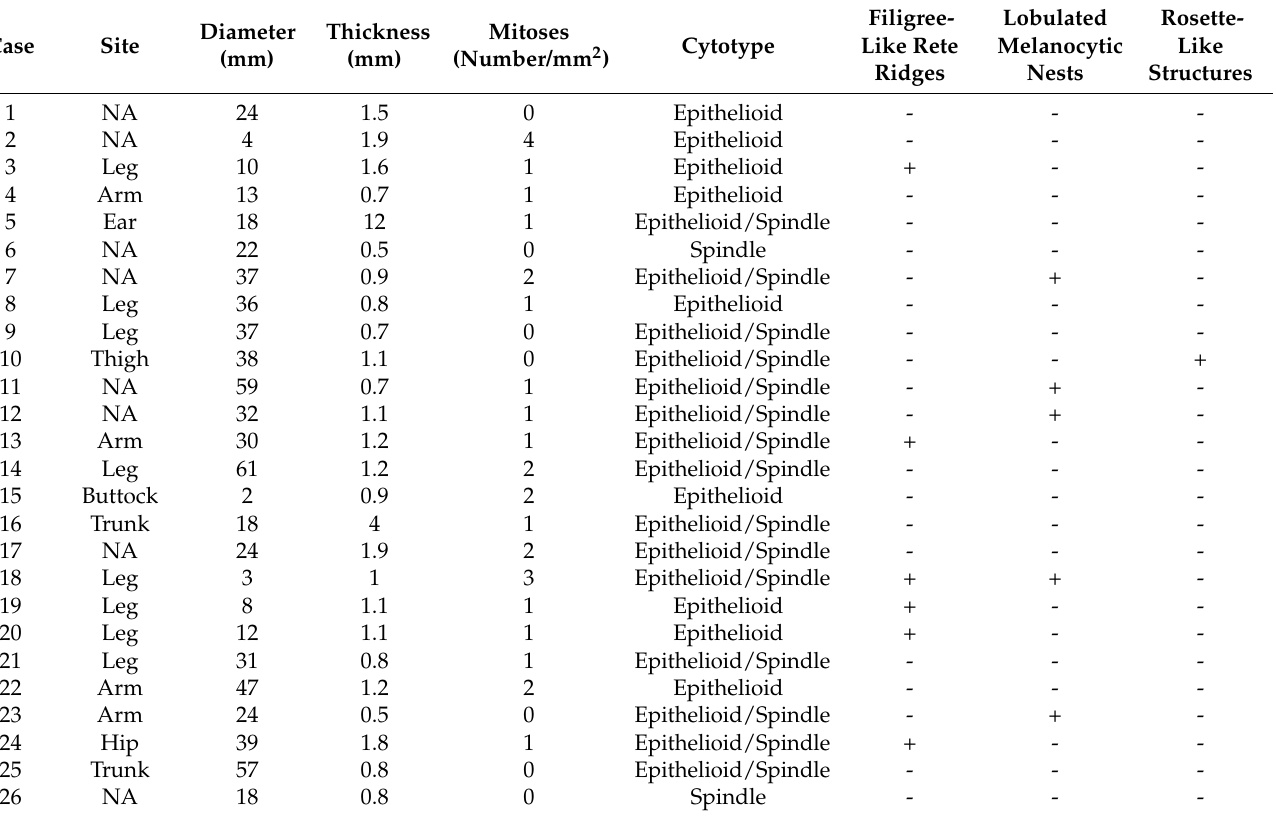
Table 2. Histopathology of the atypical Spitz tumors with positive pan-TRK